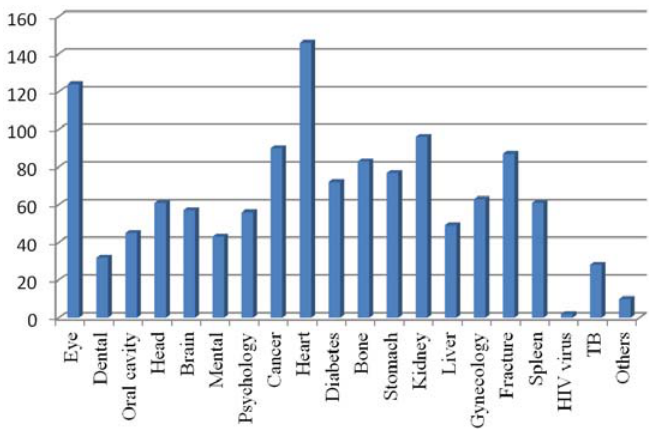
Fig. 4. Types of medical treatment/surgery demanded by Bangladeshi medical tourist Source: developed for this